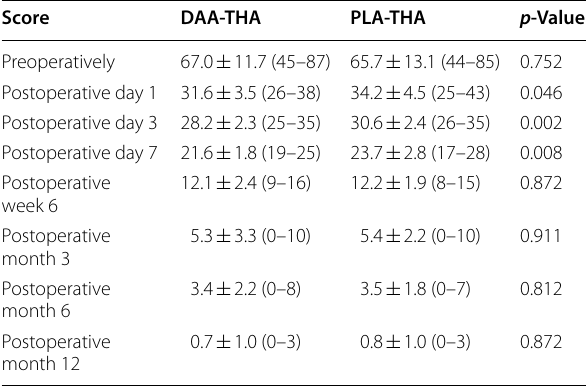
Table 3 VAS of patients’ hip pain on mobilization in the two groups